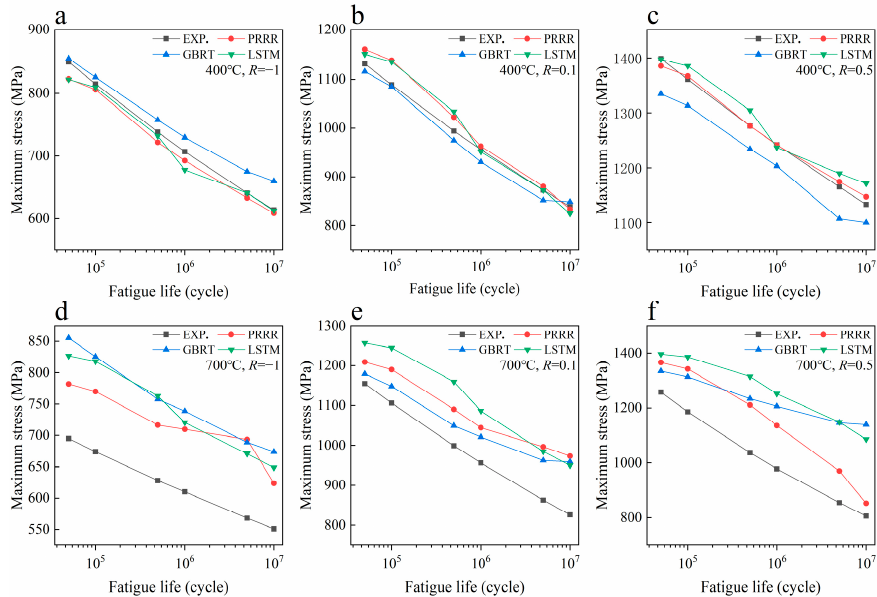
Figure 3. Predicted results of different machine learning models for the fatigue strength of the nickel ‐ based superalloy under different conditions in case 1: ( a ) 400 °C, R = − 1; ( b ) 400 °C, R = 0.1; ( c ) 400 °C, R = 0.5; ( d ) 700 °C, R = − 1; ( e ) 700 °C, R = 0.1; ( f ) 700 °C, R = 0.5. (EXP. represents the experimental data).